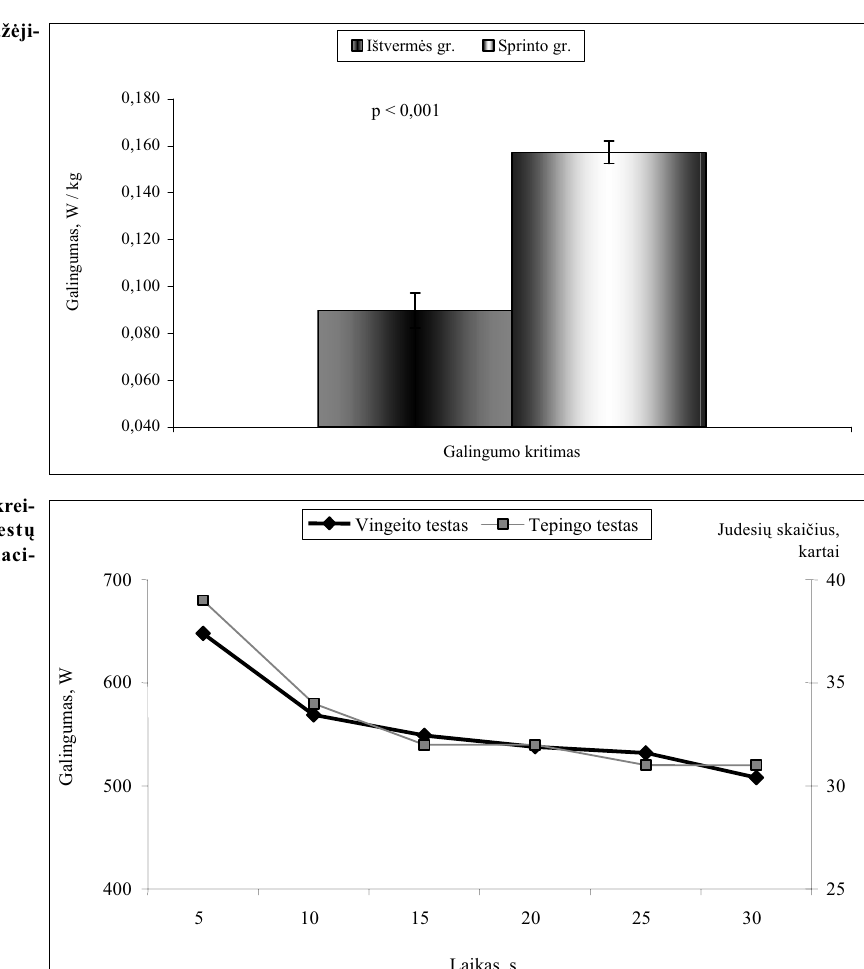
skyrėsi CNS paslankumo ir nuovargio rodikliai: CNS paslankumas geresnis sprinterių, o nuovargis 7% mažesnis ištvermės šakų sportininkų (p < 0,05), lyginant rodiklius